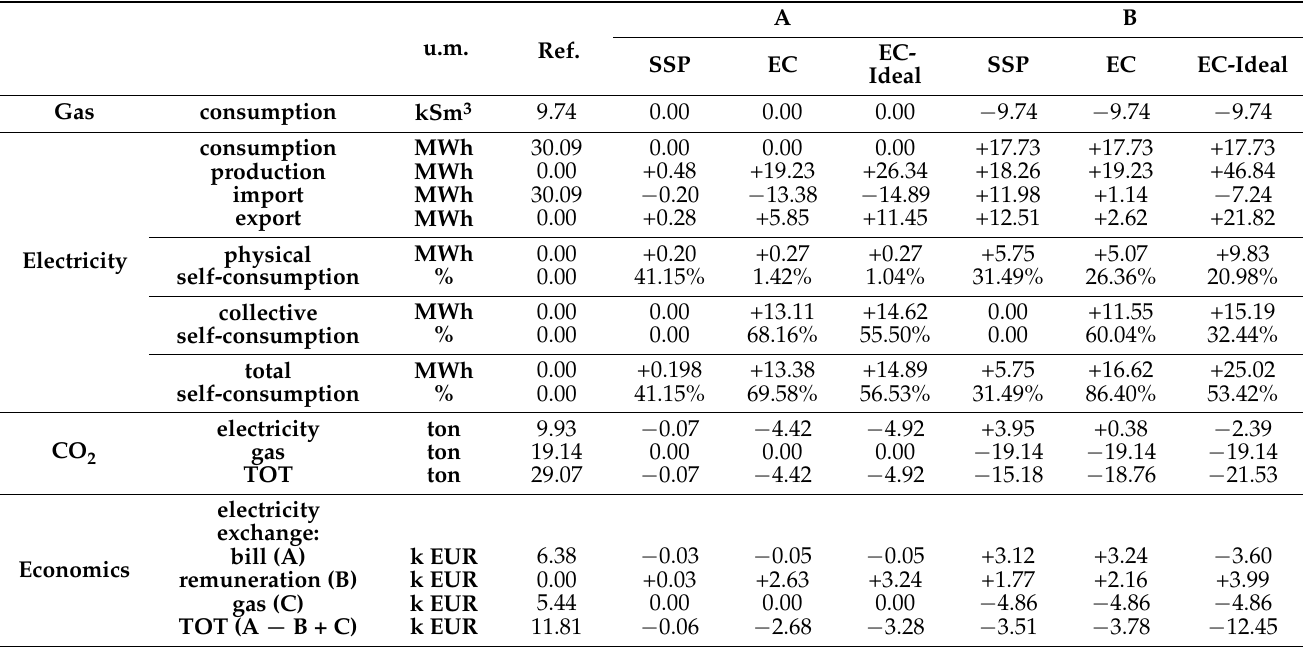
Table 7. Results of the annual simulations, in terms of gas consumption, electricity consumption and production, CO 2 emissions, and economic performances of the overall condominium. u.m.